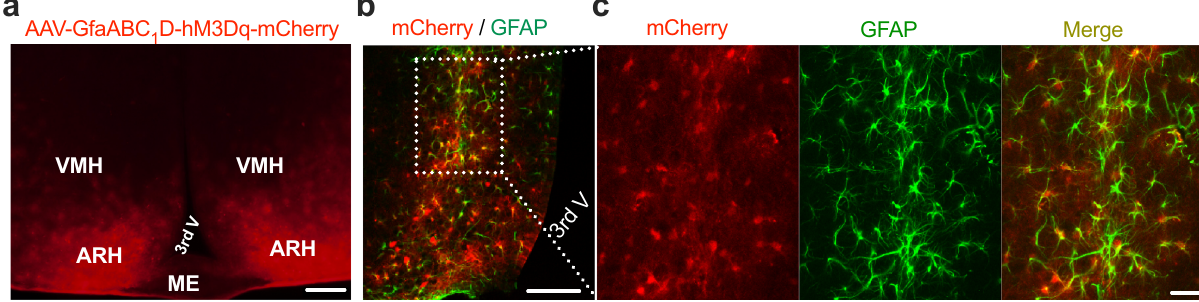
Fig. 1 | Astrocyte selective expressions ofDREADDs. a A representative confocal image of viral transductions of GfaABC 1 D-dependent hM3Dq-mCherry in the ARH. Almost all the mCherry-transduced cells (87±16.6/ fi ve sections under ×40 objec- tive, n =6)areGFAP-positive. b , c Representativeimagesshowingcolocalizationsof